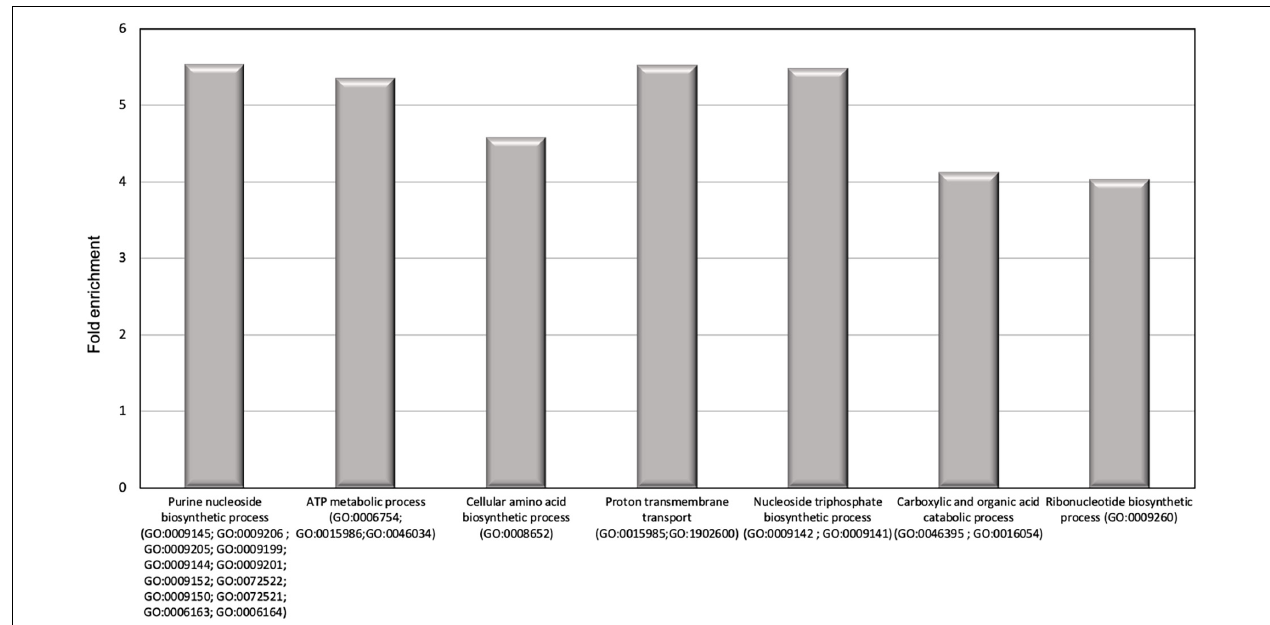
FIGURE 7 | Results of the overrepresentation test (Panther) of the 648 proteins specifically expressed in oval morphotype. Only proteins families with a fold enrichment upper than 4 are represented.